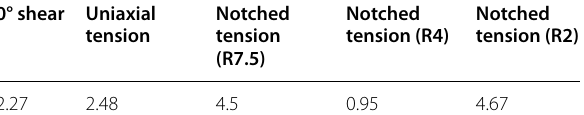
Table 5 Mean square deviation of simulation and test results for the force-displacement curves under different stress states (%) 0° shear Uniaxial tension